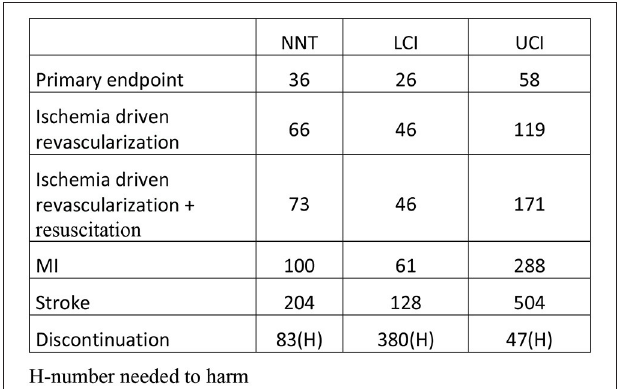
FIGURE 4 | The number needed to treat (NNT) for analyzed